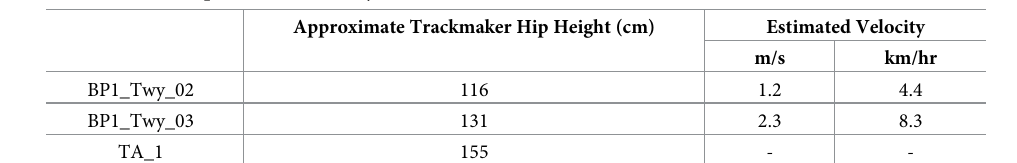
Table 3. BP1 theropod size and velocity